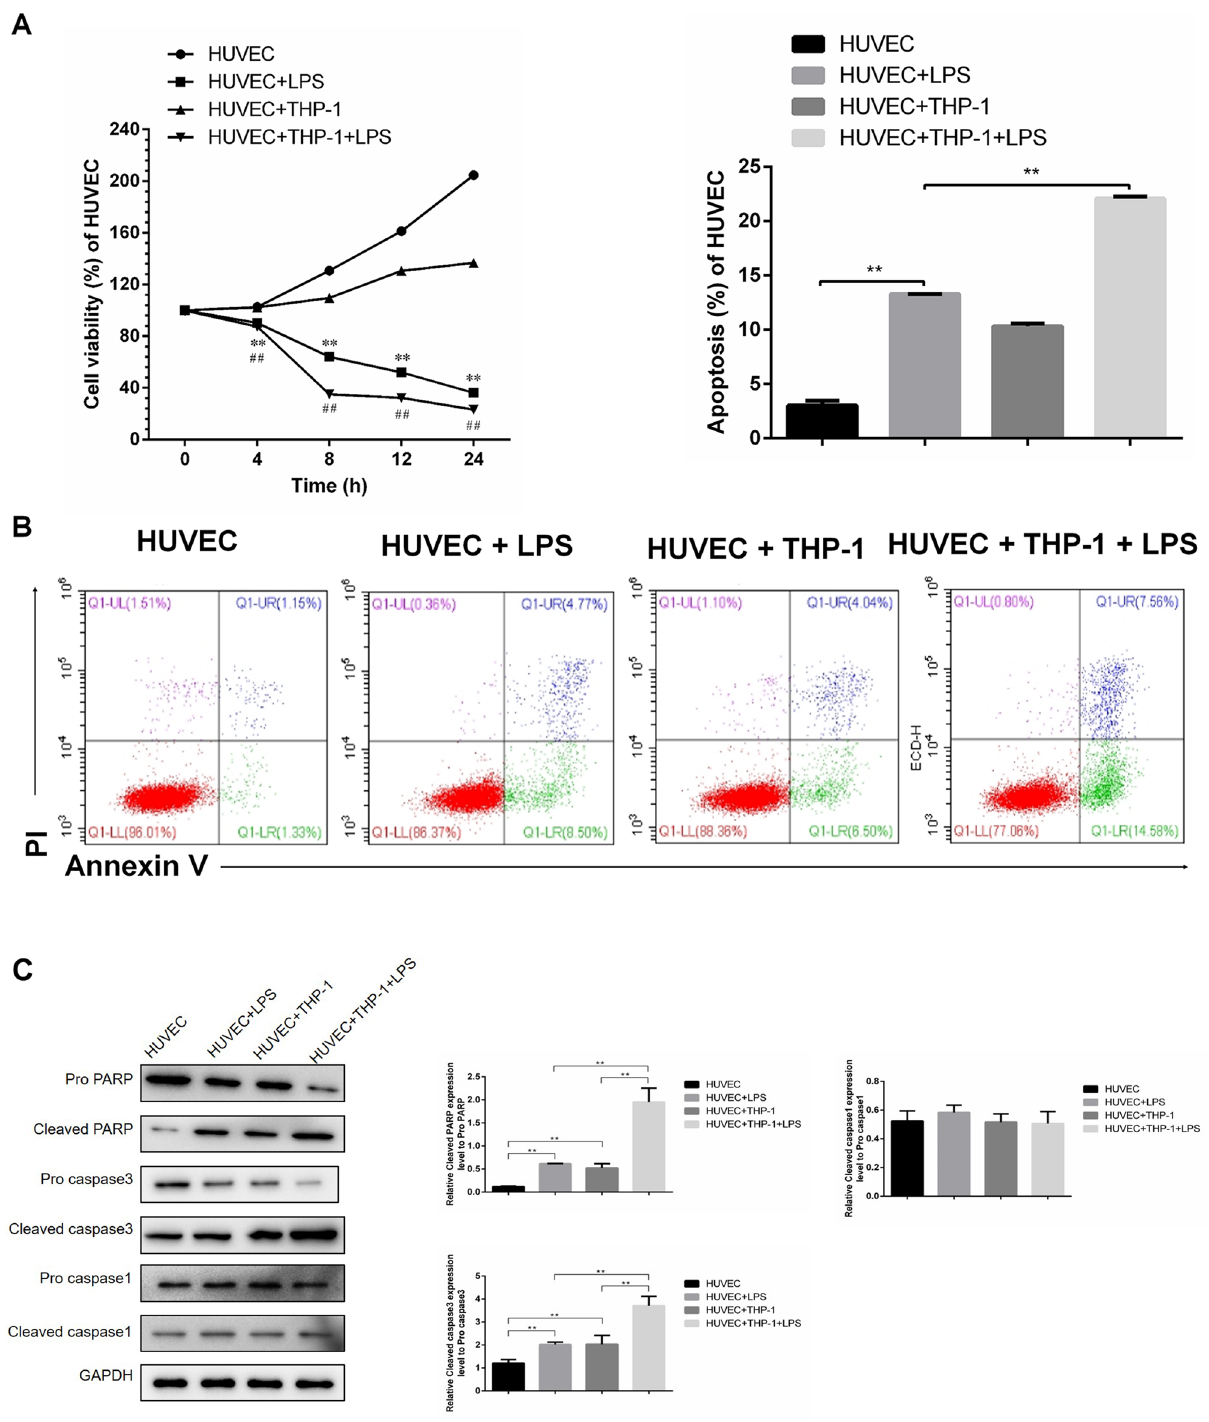
Figure 1. THP-1-derived macrophages enhanced LPS-induced proliferation impairment and apoptosis of HUVECs. Four groups of HUVECs, including control HUVEC without treatment or co-culturing (HUVEC), HUVEC treated with 100 μg/mL LPS alone (HUVEC + LPS), HUVEC co-cultured with THP-1-derived macrophages (HUVEC + THP-1) and LPS stimulated HUVECs that co-cultured with THP-1-derived macrophages (HUVEC + THP-1 + LPS), were measured for cell proliferation by CCK-8 assay ( A ) and apoptosis by flow cytometry ( B ) after 8 h culture. Apoptosis of HUVECs was quantitated by Annexin V and PI staining via flow cytometry. Annexin V + cells are considered as apoptotic cells. n = 3 for each group. Data are expressed as mean ±